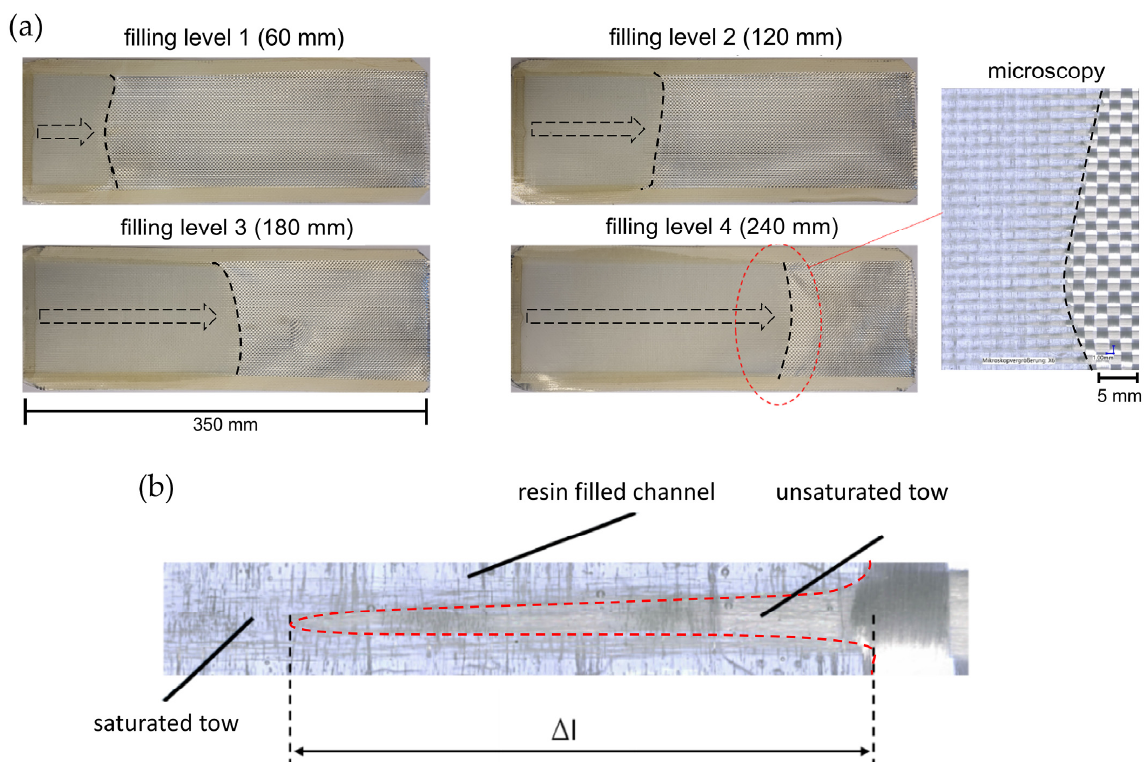
Figure 7. ( a ) Frozen flow front in different mold sections and merged microscopy image; ( b ) single flow path difference Δ l , shown magnified.